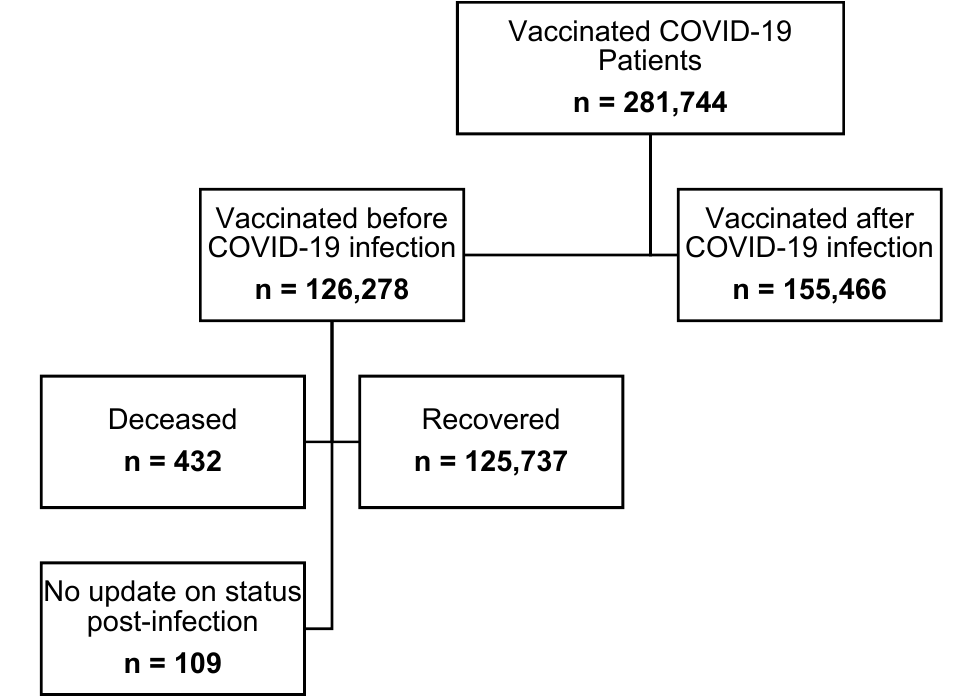
Figure 1. Schematic diagram of sample recruitment.